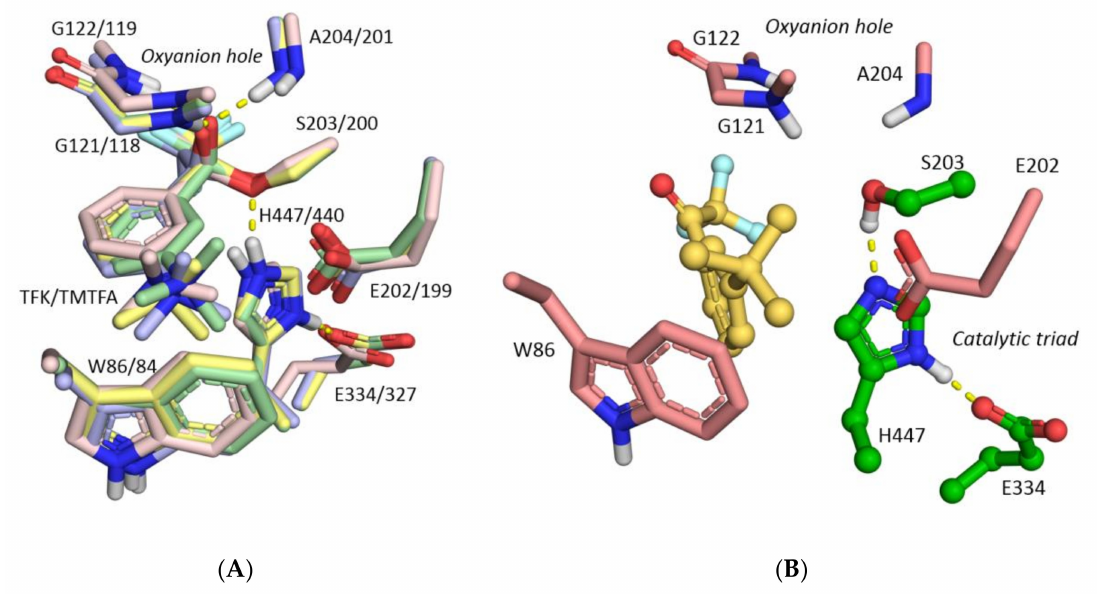
Figure 8. ( A ) Tetrahedral adducts for reaction between TFK (carbon atoms shown in yellow) and TMTFA (carbon atoms shown in green) and hAChE obtained by QM / MM calculations overlaid with X-ray structures of conjugates of TMTFA with Mus musculus (PDB ID: 2H9Y [53], carbon atoms shown in blue) and Torpedo californica (PDB ID: 1AMN [6], carbon atoms shown in pink). Double hAChE / TcAChE numbering is provided; ( B ) Non-covalent complex between TFK and hAChE, stable product resulting from the tetrahedral adduct reactivation